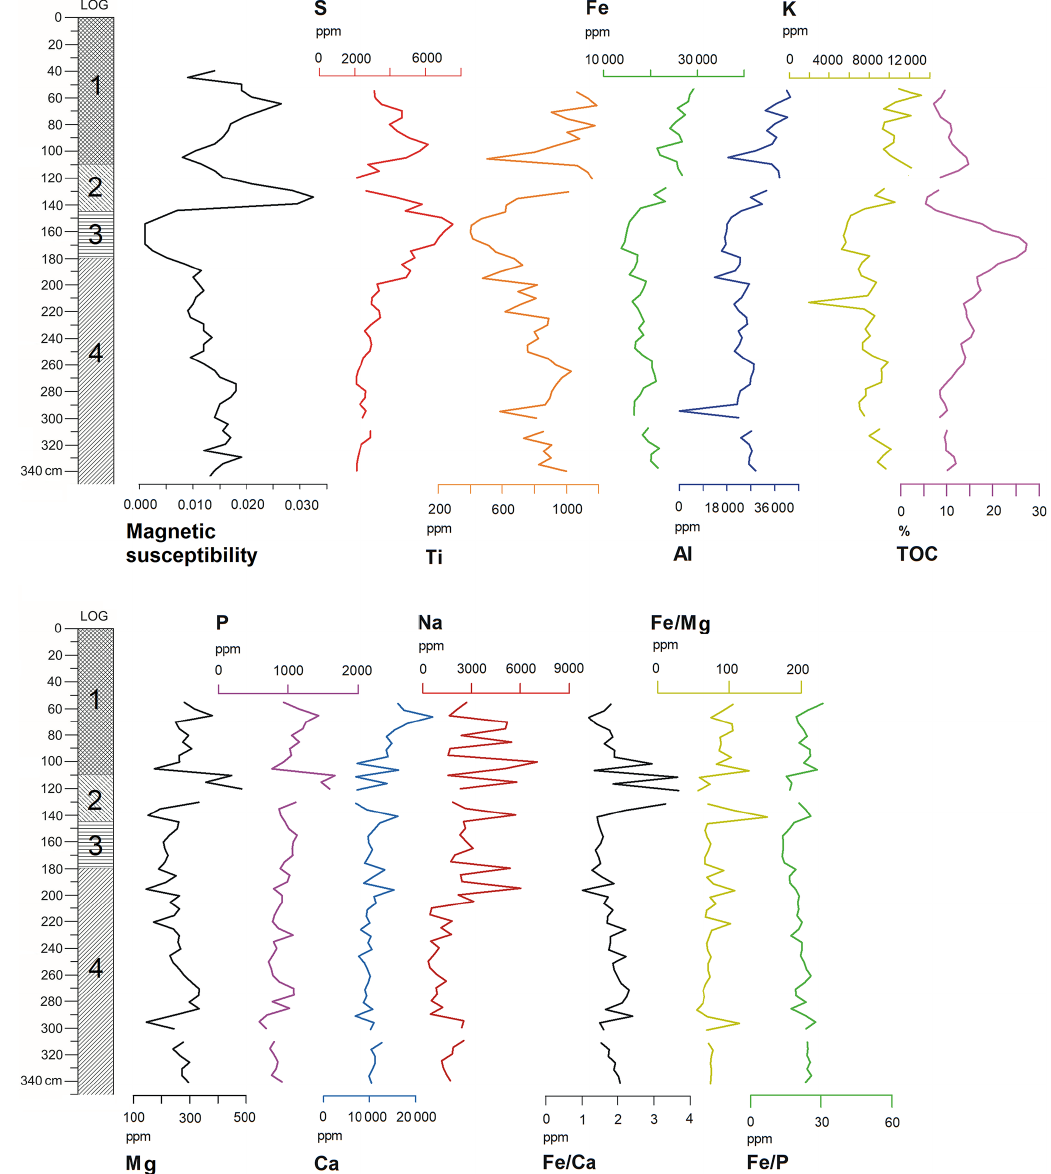
Figure 6. Concentration depth curves for selected elements and TOC in the core M1 of Lake Młynek sediments. Description of LOG: 1 – hydrated, detritus-type gyttja; 2 – very plastic, algal gyttja; 3 – grey-brown peaty, detritus gyttja; 4 – grey-brown gyttja (drawing: Fabian